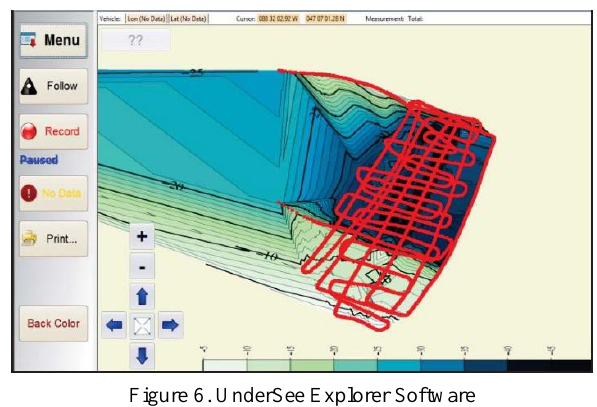
Figure 6. UnderSee Explorer